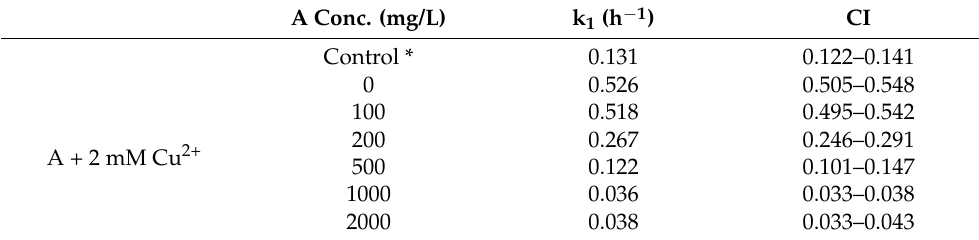
Table 6. First-order rate constants for vitamin D3 degradation in the presence of Cu 2+ ions (alone— point 0) and in combination with different concentrations of ascorbic acid (A) at 25 ◦ C ( n = 3). A Conc. (mg/L) k 1 (h − 1